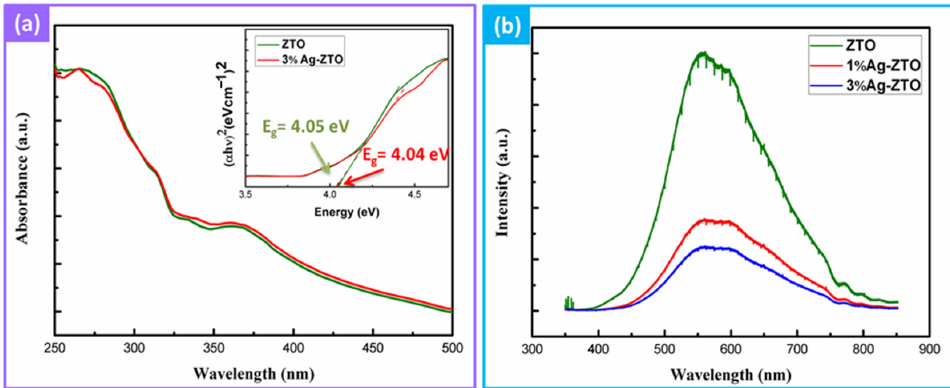
Figure 4. Optical properties of ZTO NWs and Ag-ZTO NWs. ( a ) UV–Vis spectra ( b ) PL spectra.